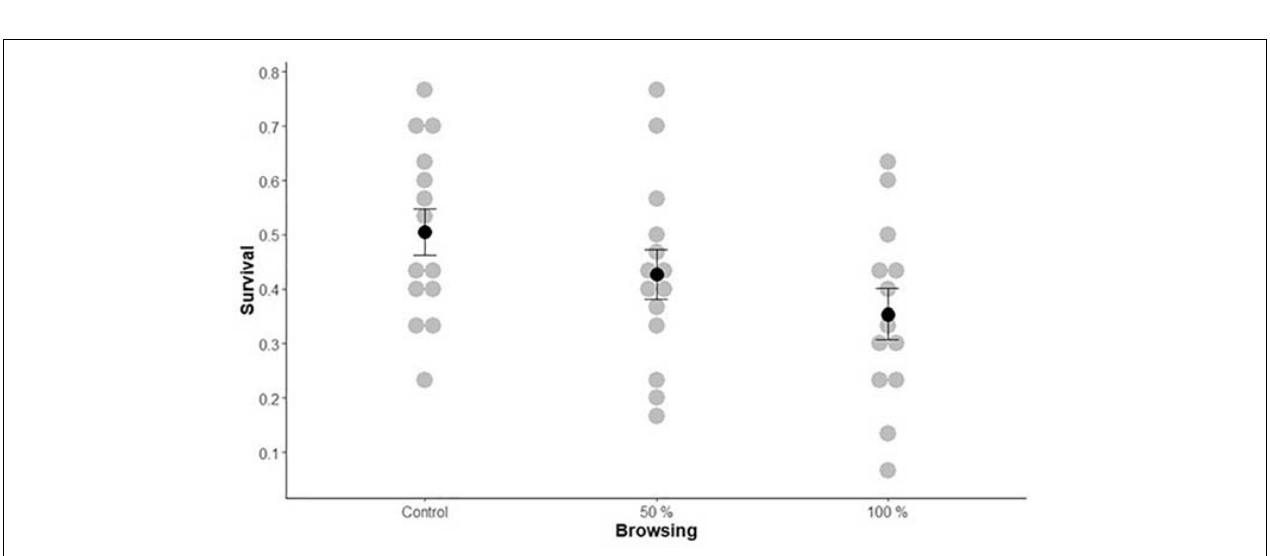
FIGURE 3 | Survival of larvae on un-browsed, moderately and intensively browsed trees. Mean survival was 51, 43, and 35%. Gray dots represent survival on individual trees, and the black dots represent mean survival for each browsing intensity. Error bars represent standard error.